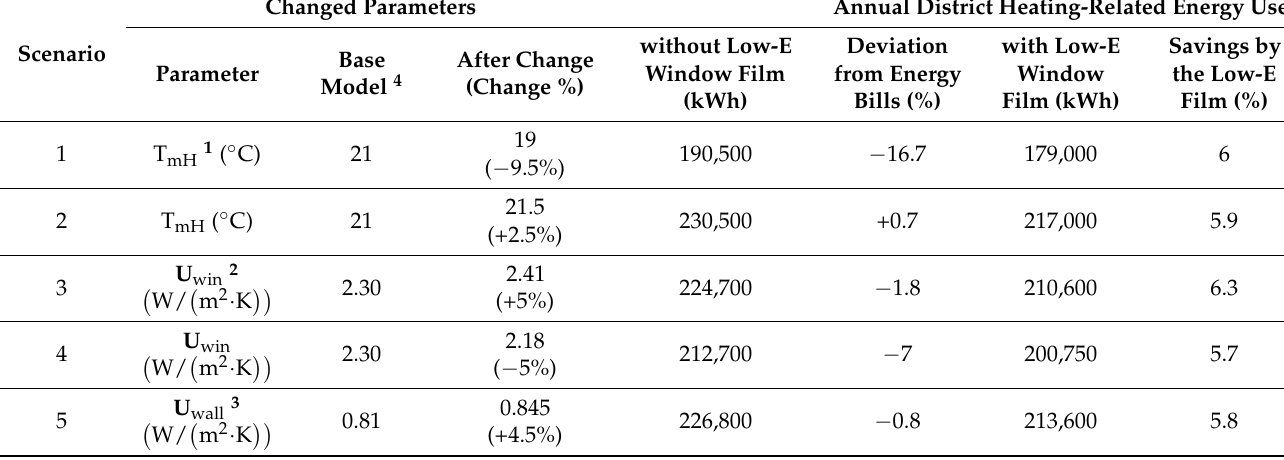
Table A1. Summary of sensitivity analysis regarding impact of total heating variation on energy savings attained by film